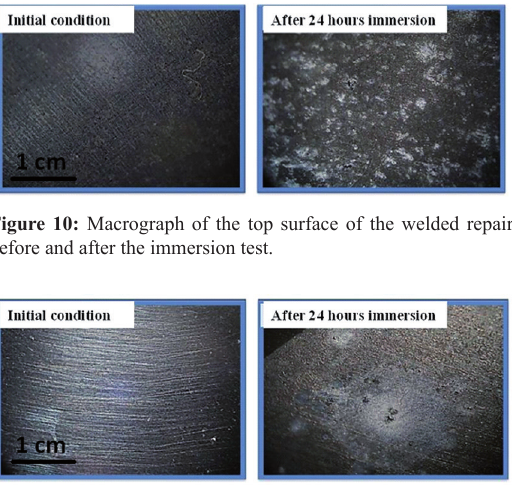
Figure 11: Macrograph of the top surface of the cold spray repair before and after the immersion test.